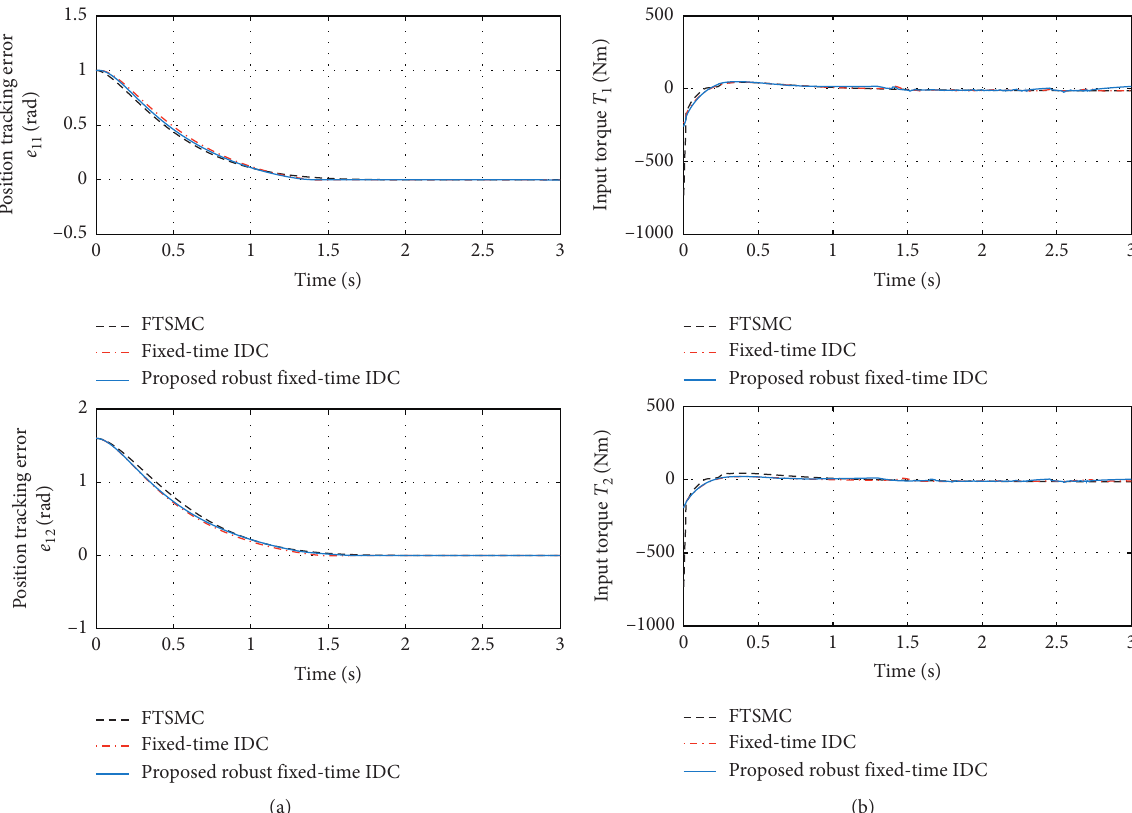
Figure 1: Responses of small initial condition in case 1 ( q ( 0 ) � [ 0 , 0 ] rad ) . (a) Position tracking errors. (b) Input torques.